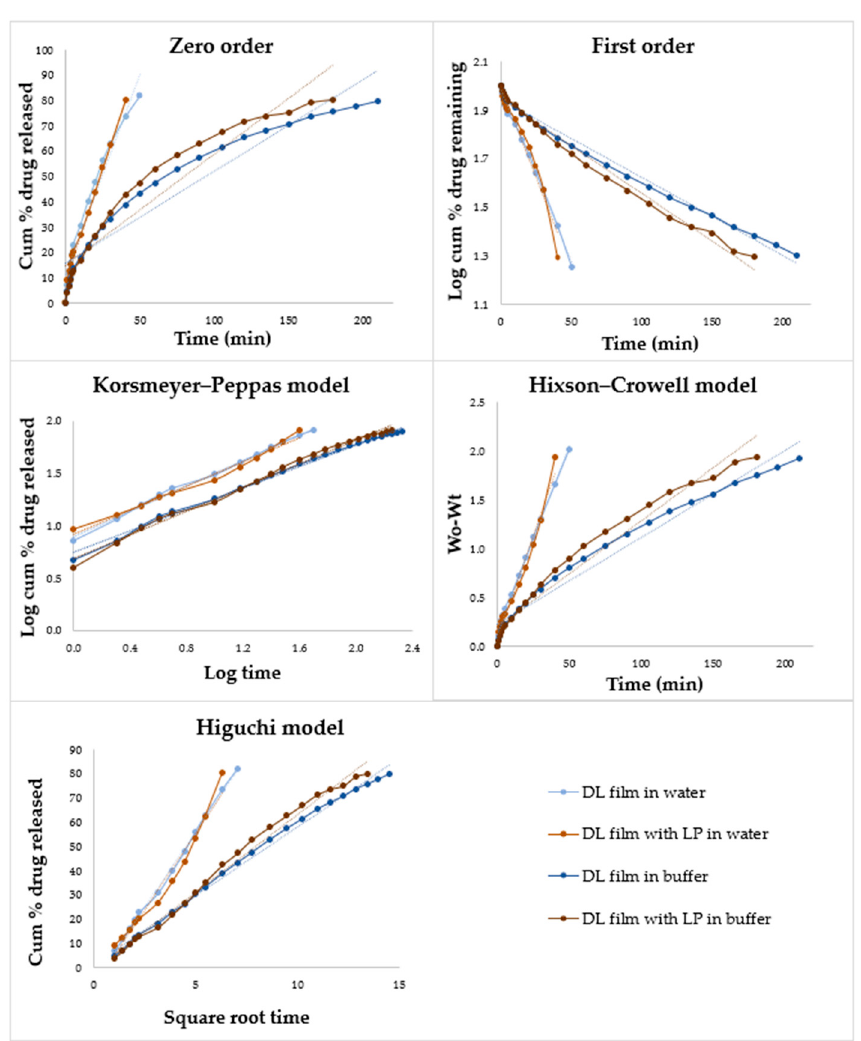
Figure 8. Drug release data fitted to various kinetic models (zero order, first order, Korsmeyer–Peppas (Kors–Peppas), Hixson–Crowell (Hixson), and Higuchi) obtained from the dissolution studies of the drug-loaded films with and without liver powder in water and in buffer. Table 7. In vitro release kinetic values.